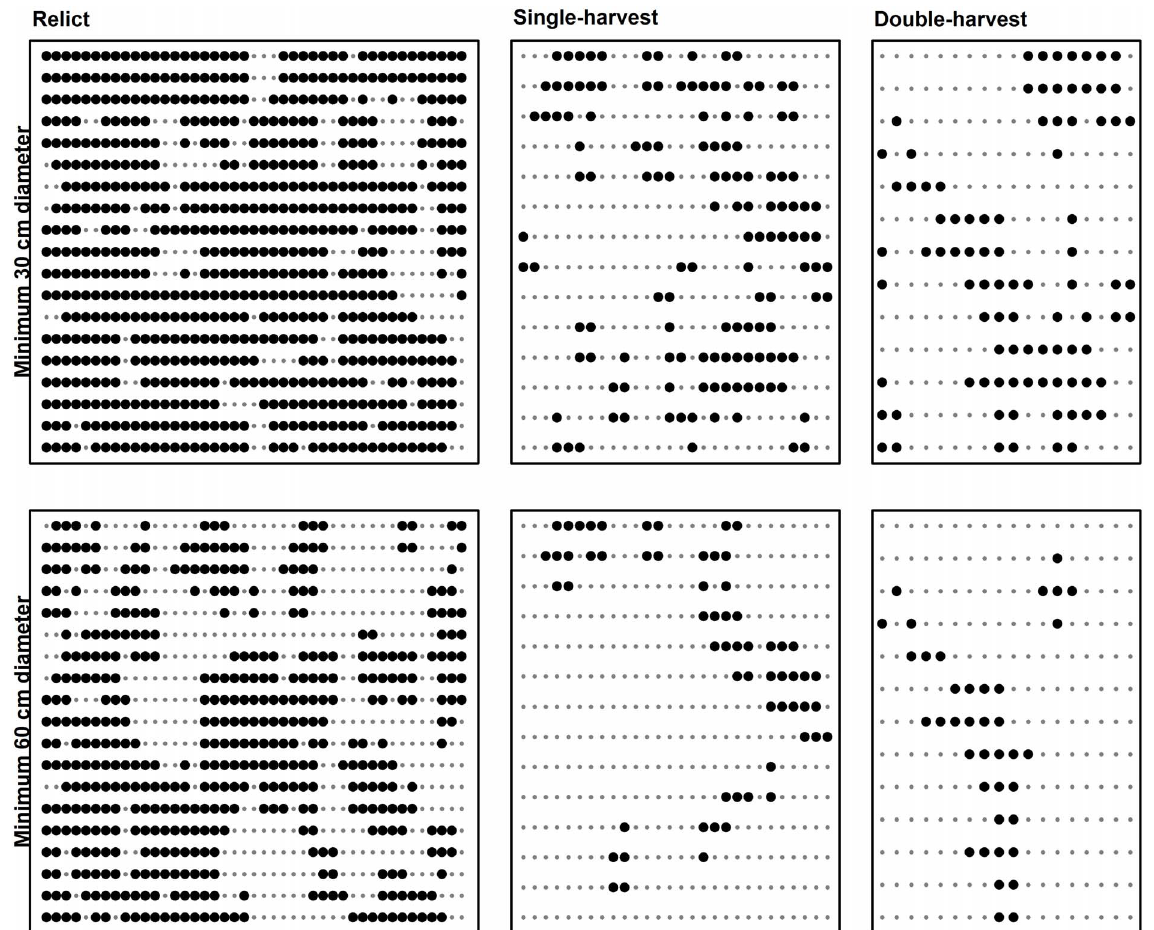
Figure 4. Downed deadwood connectivity examples. Display of connected plots for downed deadwood (DDW) in relict, single-harvest, and double-harvests stands for pieces $ 30 cm (top row) and $ 60 cm (bottom row) based on large end diameter. Large dots indicate plots that sampled at least one DDW piece of the stated size, and small dots indicate plots with no DDW pieces of designated size sampled.